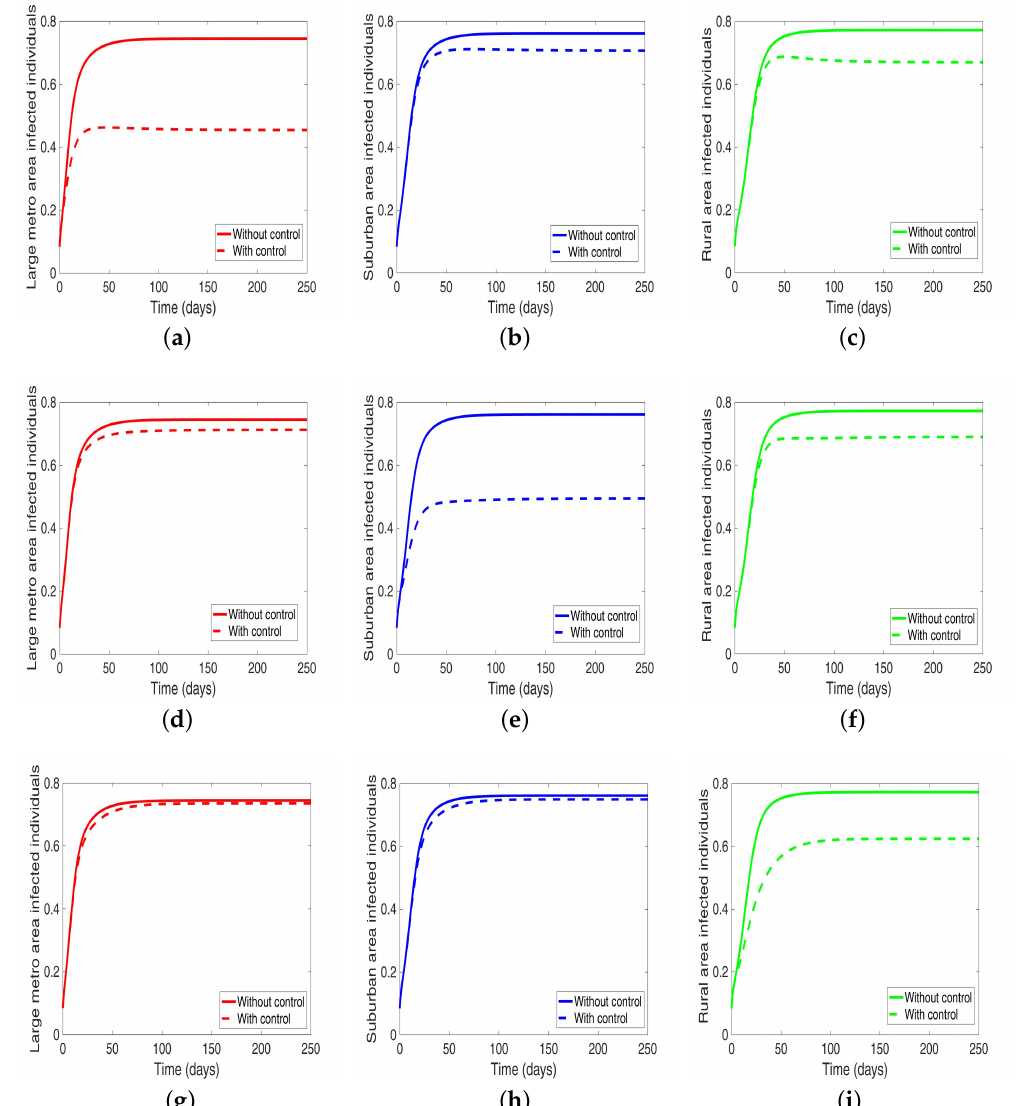
Figure 8. MRSA model simulation with movement and behavioral control in large metro area only ( a – c ). Movement and behavioral control in suburban area only ( d – f ). Movement and behavioral control in rural area only ( g – i ). ( a ) Infected individuals in large metro area. ( b ) Infected individuals in suburban area. ( c ) Infected individuals in rural area. ( d ) Infected individuals in large metro area. ( e ) Infected individuals in suburban area. ( f ) Infected individuals in rural area,=. ( g ) Infected individuals in large metro area. ( h ) Infected individuals in suburban area. ( i ) Infected individuals in rural area. Parameter values used are given in Tables 2–4. Table 7. Final population size when controlling behavior one at a time when the regions are connected. With Control in With Control in With Control Regions Without Control